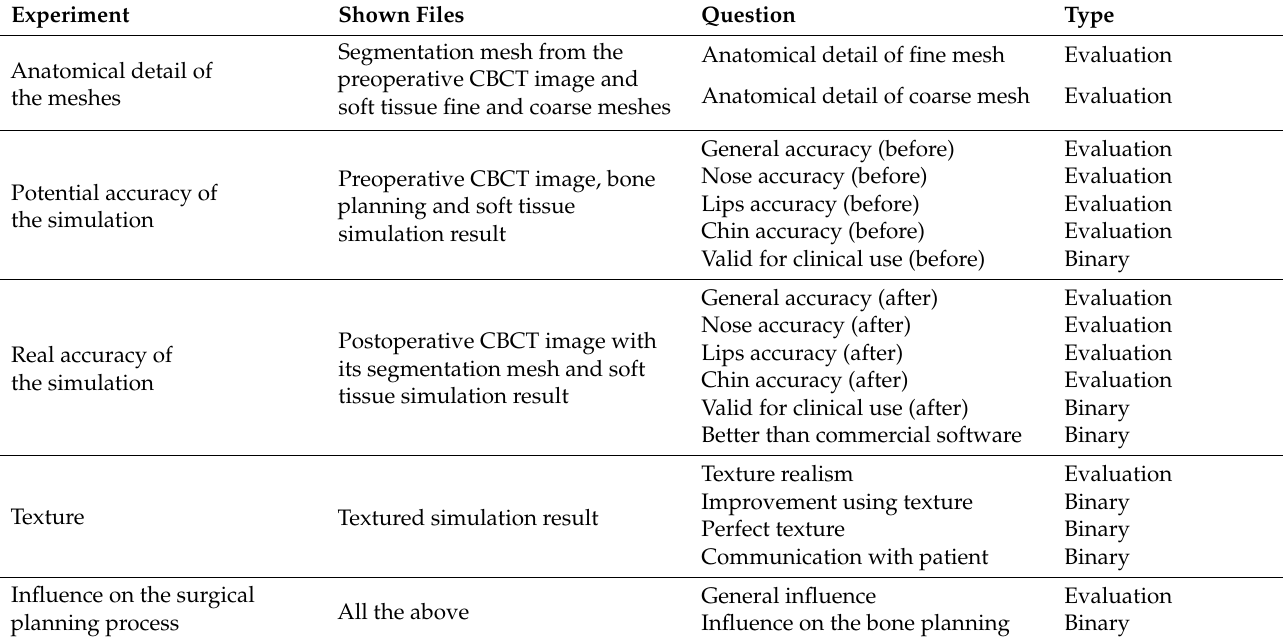
Table 1. Summary of the experiments and questions. In the columns: experiments performed, files shown during each experiment, questions asked to the surgeons and type of question (evaluation or binary). Some questions were asked both before showing the actual surgical outcome (before) and after showing it